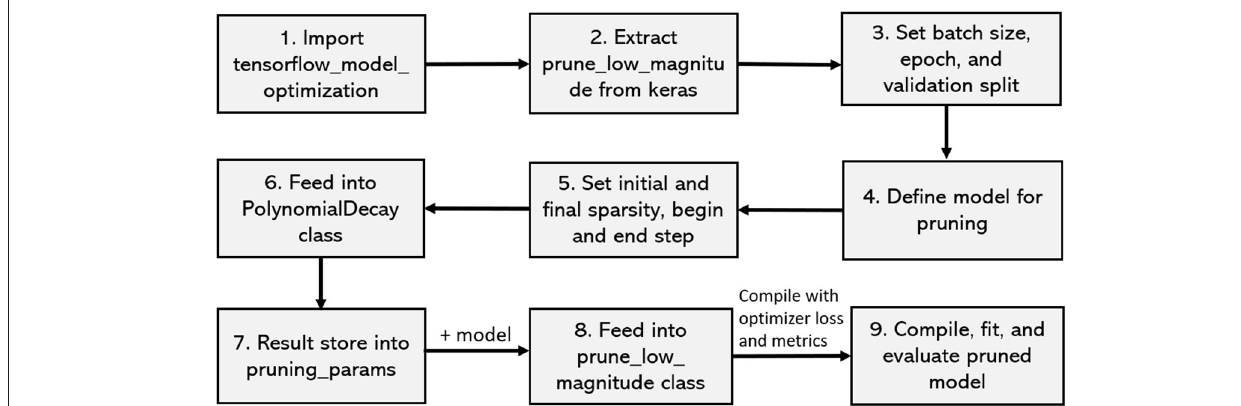
FIGURE 6 | Steps of performing model pruning.